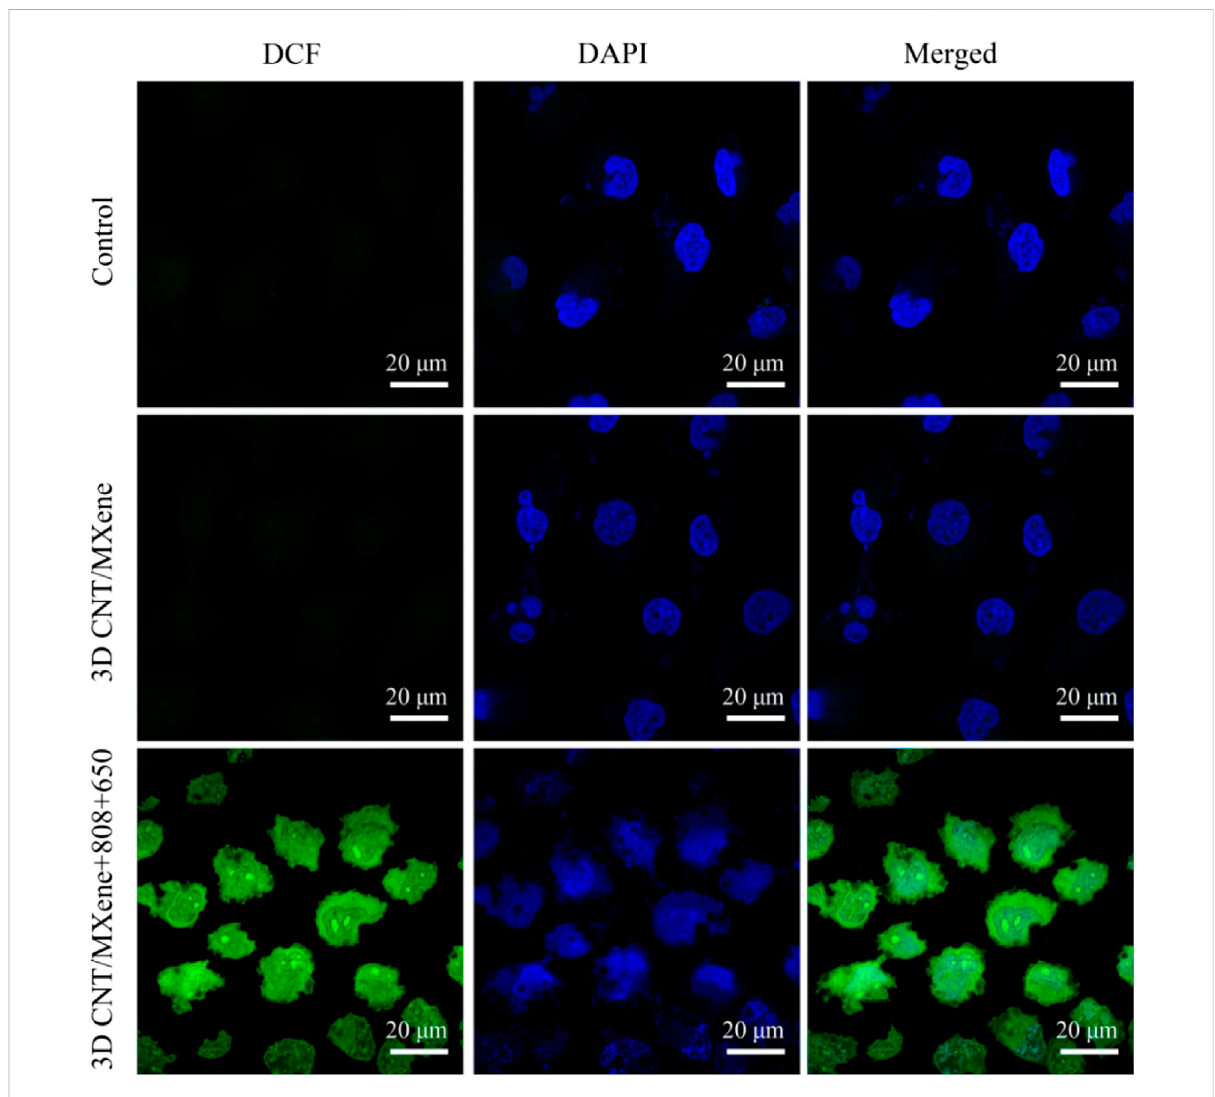
FIGURE 9 Fluorescent confocal microscopy images of HeLa cells that received different